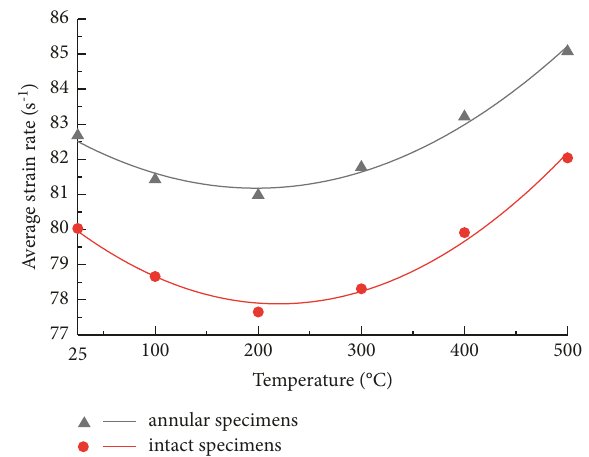
Figure 12: Average strain rate of sandstone specimens after dif- ferent